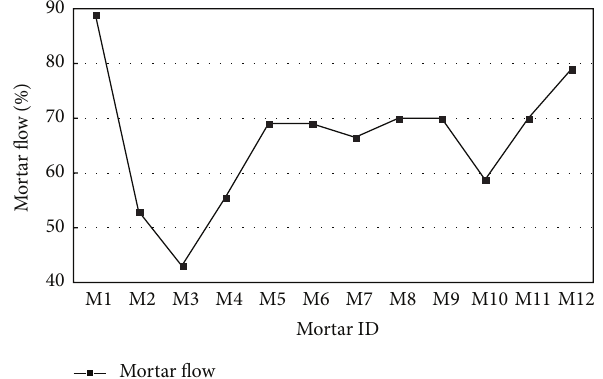
Figure 7: Mortar flow for different mix proportions.